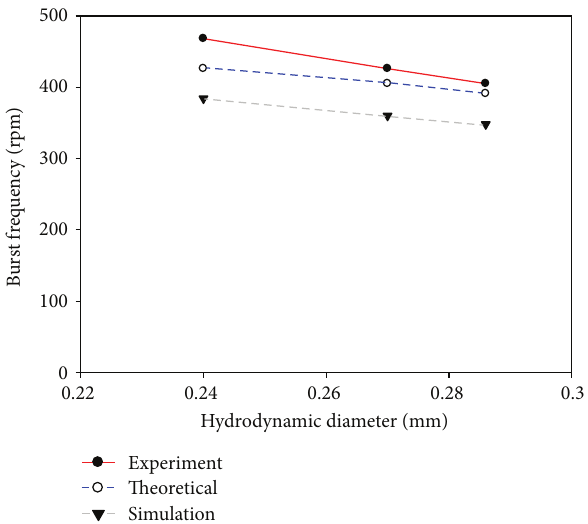
Figure 15: Burst frequency decreases with a lower fluid viscosity when the type of titrant is mercurochrome.